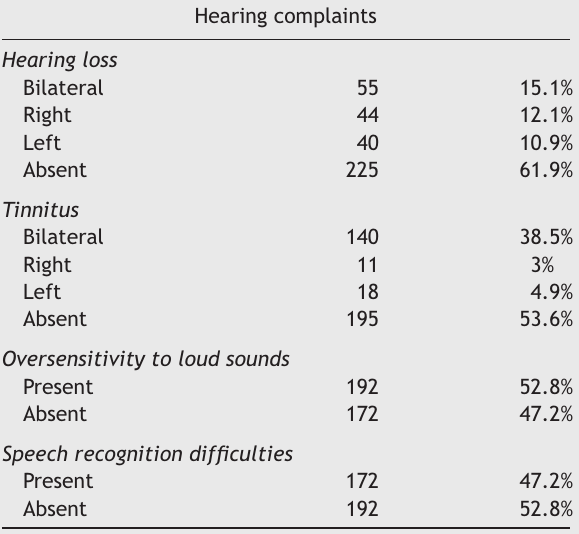
Distribution of workers by hearing